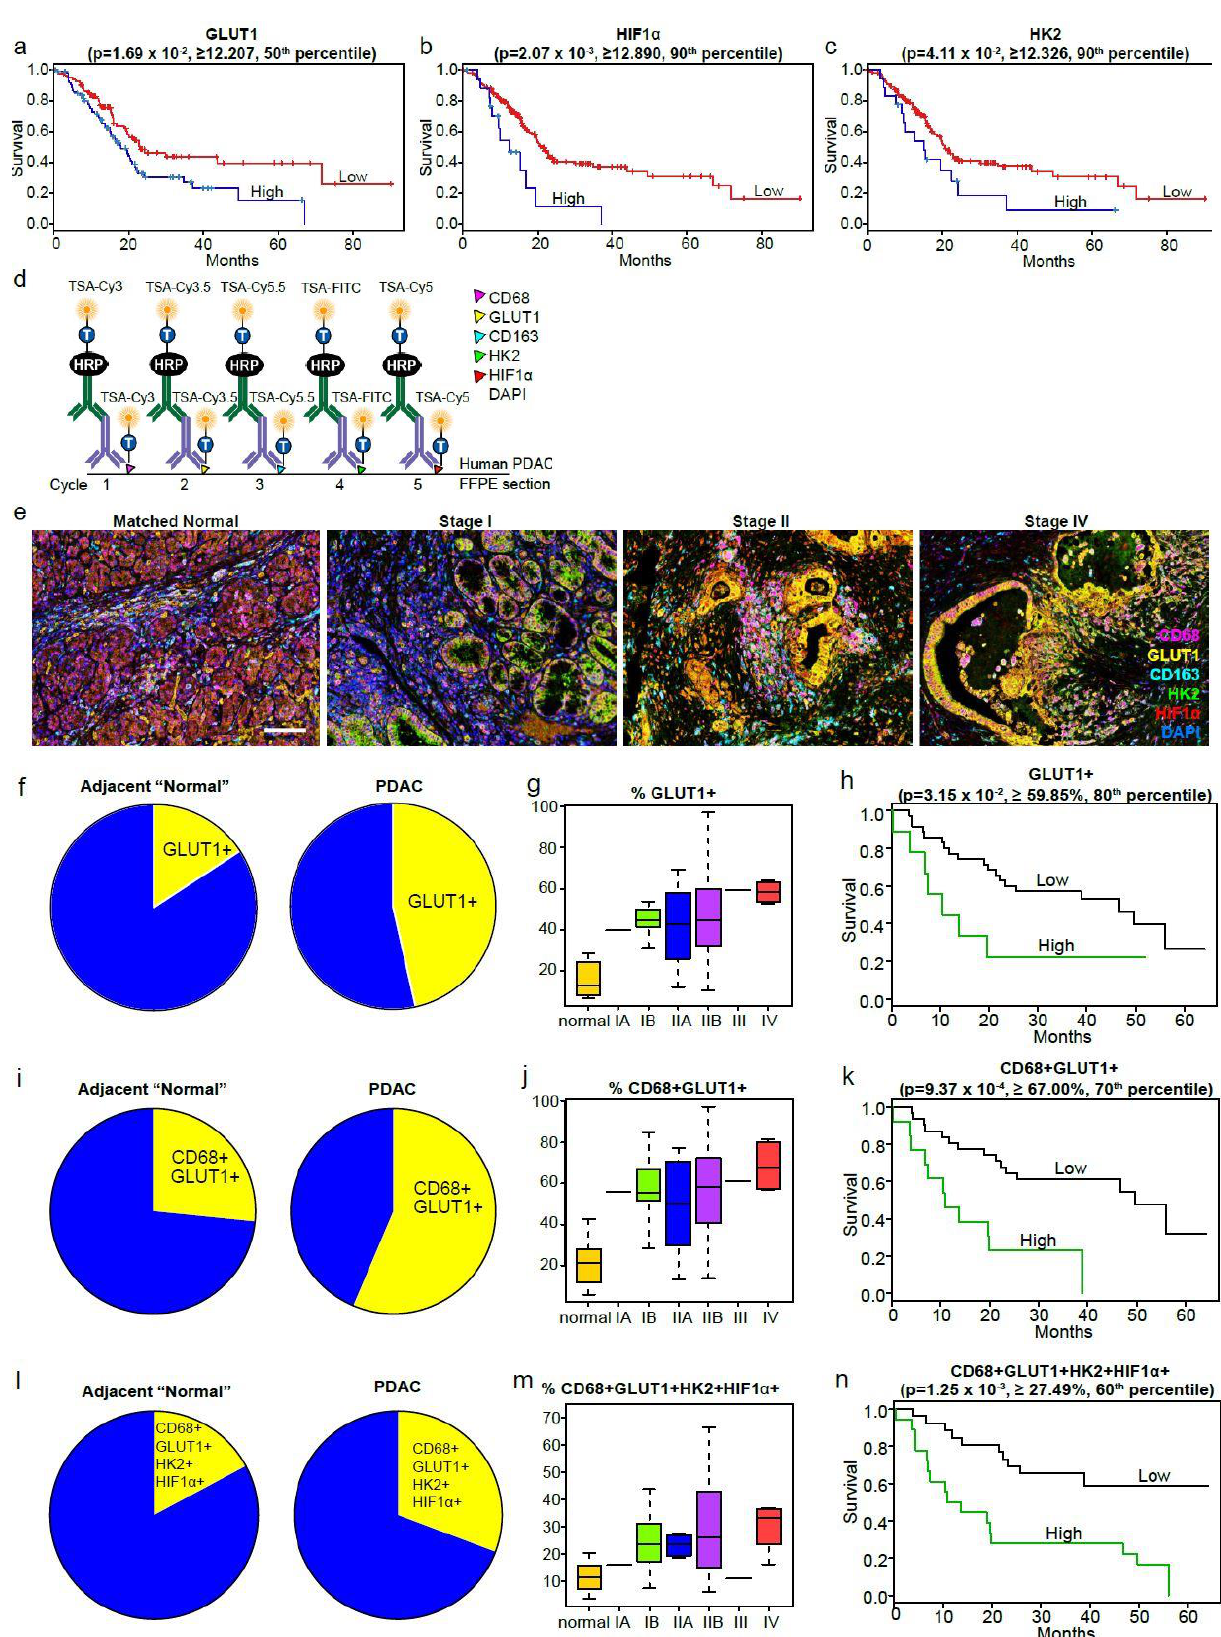
Figure 6. The macrophage glycolytic signature is a predictor of poor survival in human PDAC. ( a – c ) Gene expression and clinical survival data was extracted from the TCGA cohort, a publicly available dataset. Expression of GLUT1 ( a ), HIF1 α ( b